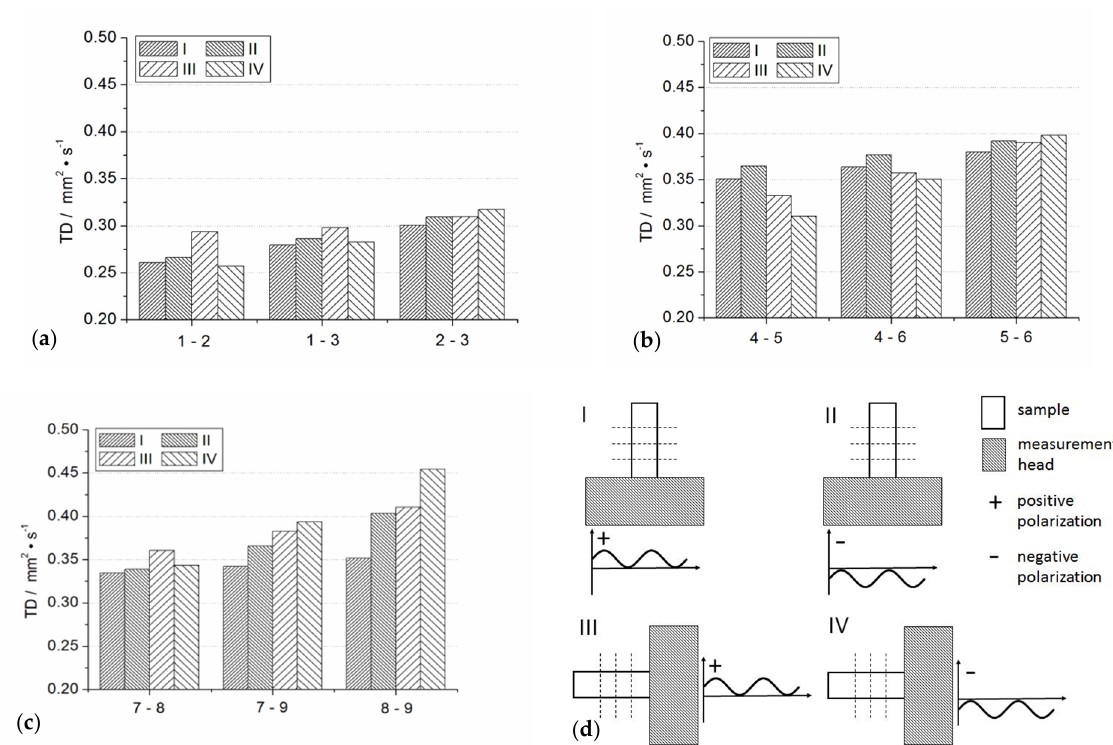
Figure 11. Results of in-plane TD measurements performed on composite specimens A ( a ) and B ( b , c ) compared with specimens’ arrangement in Figure 10; measurement configurations ( d ).